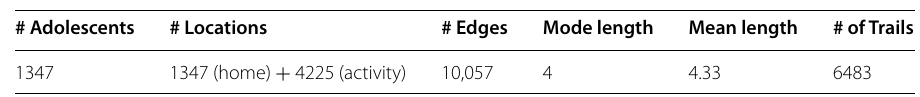
Mode and mean are computed on the distribution of length of all the trails